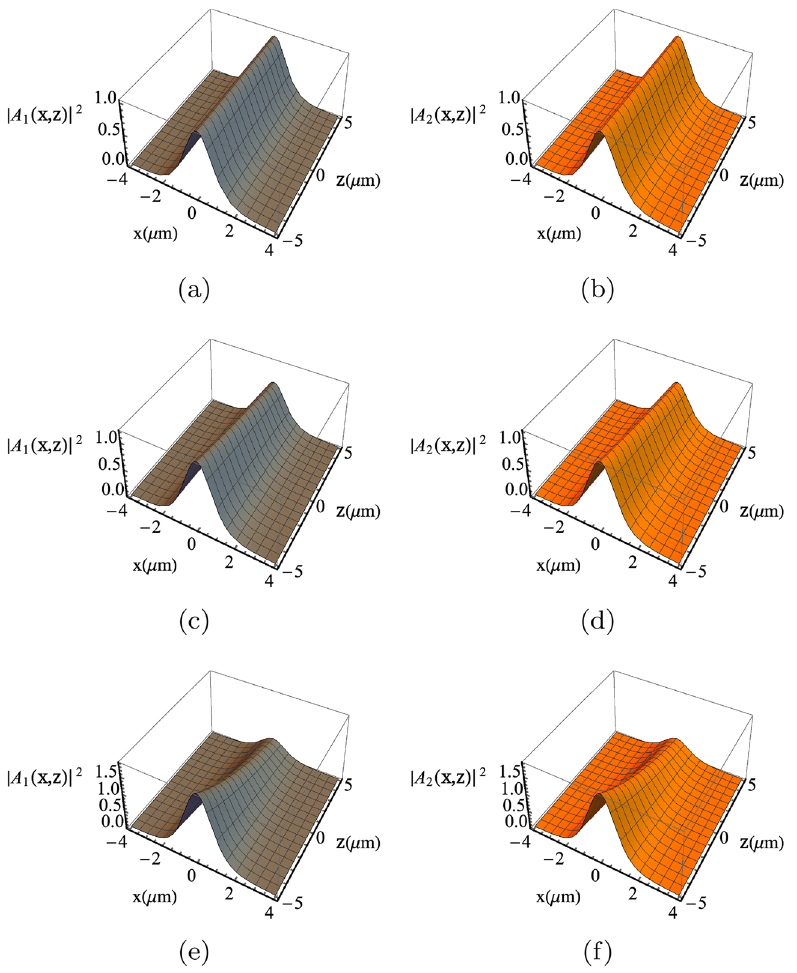
100 . Other parameters are the same 10 µ m and N = =